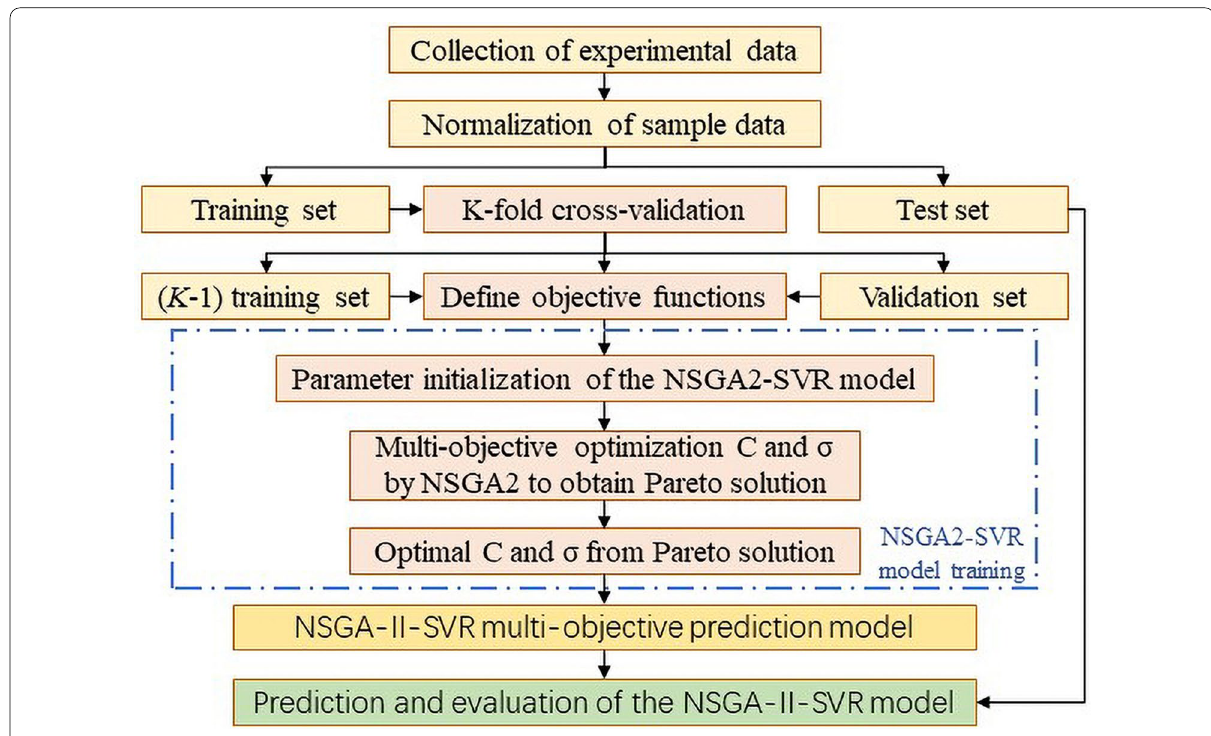
Fig. 3 Modeling flowchart of NSGA2-SVR multi-objective prediction model